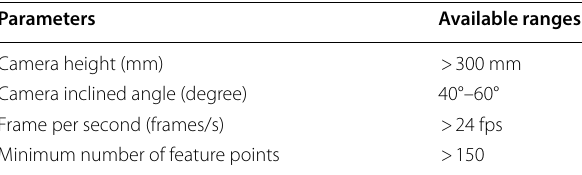
Table 5 Range of parameters meeting the error rate requirement Parameters Available